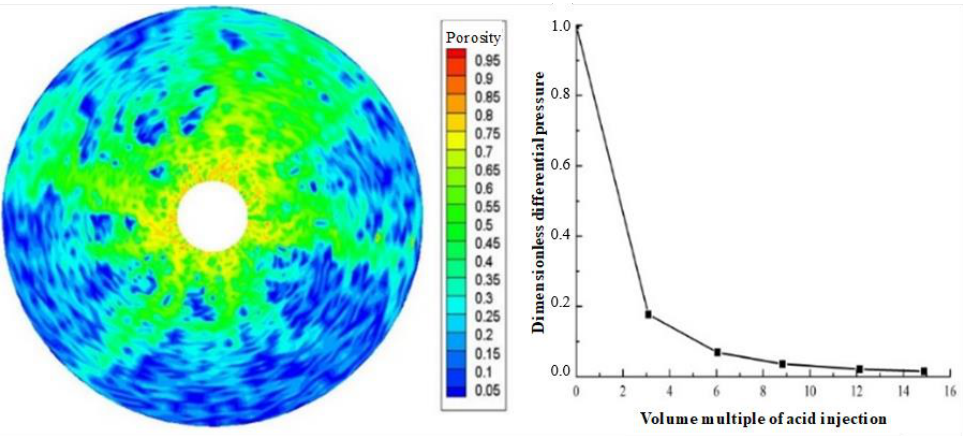
Figure 8. Change of dissolution form and differential pressure with gelling acid injection (gelling acid injection speed 65 cm/min).